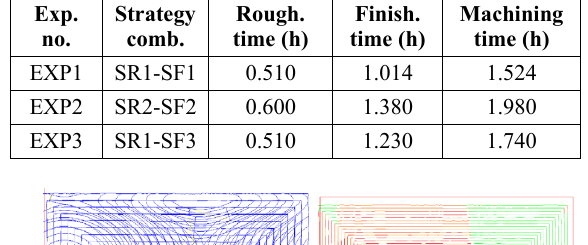
Table 4. Roughing and finishing times for different machining strategies